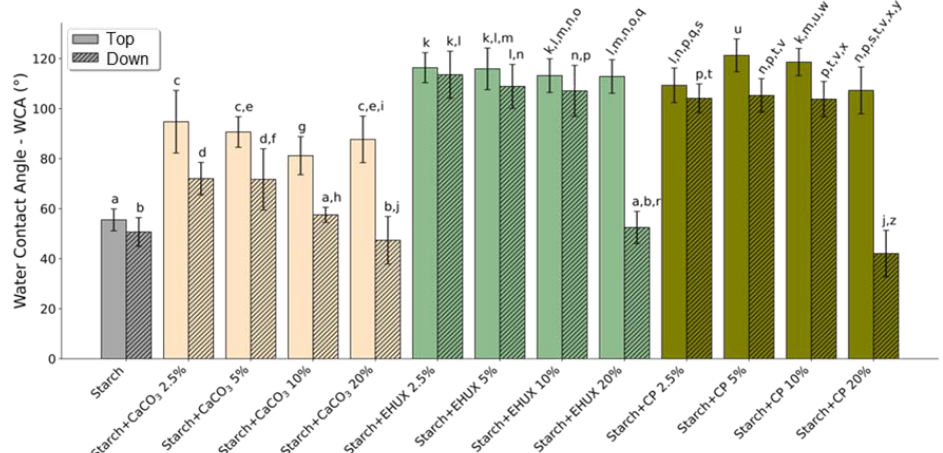
Figure 4. Water contact angle (WCA) values of Top (clear bars) and Down (stripped bars) surfaces of starch films (control) and starch-based films containing commercial CaCO 3 , E. huxleyi (EHUX) or C. pseudoroscoffensis (CP) at different percentages (2.5, 5, 10, and 20% w / w ). Different letters between each condition indicate significant differences (Student’s t -test; p < 0.05).